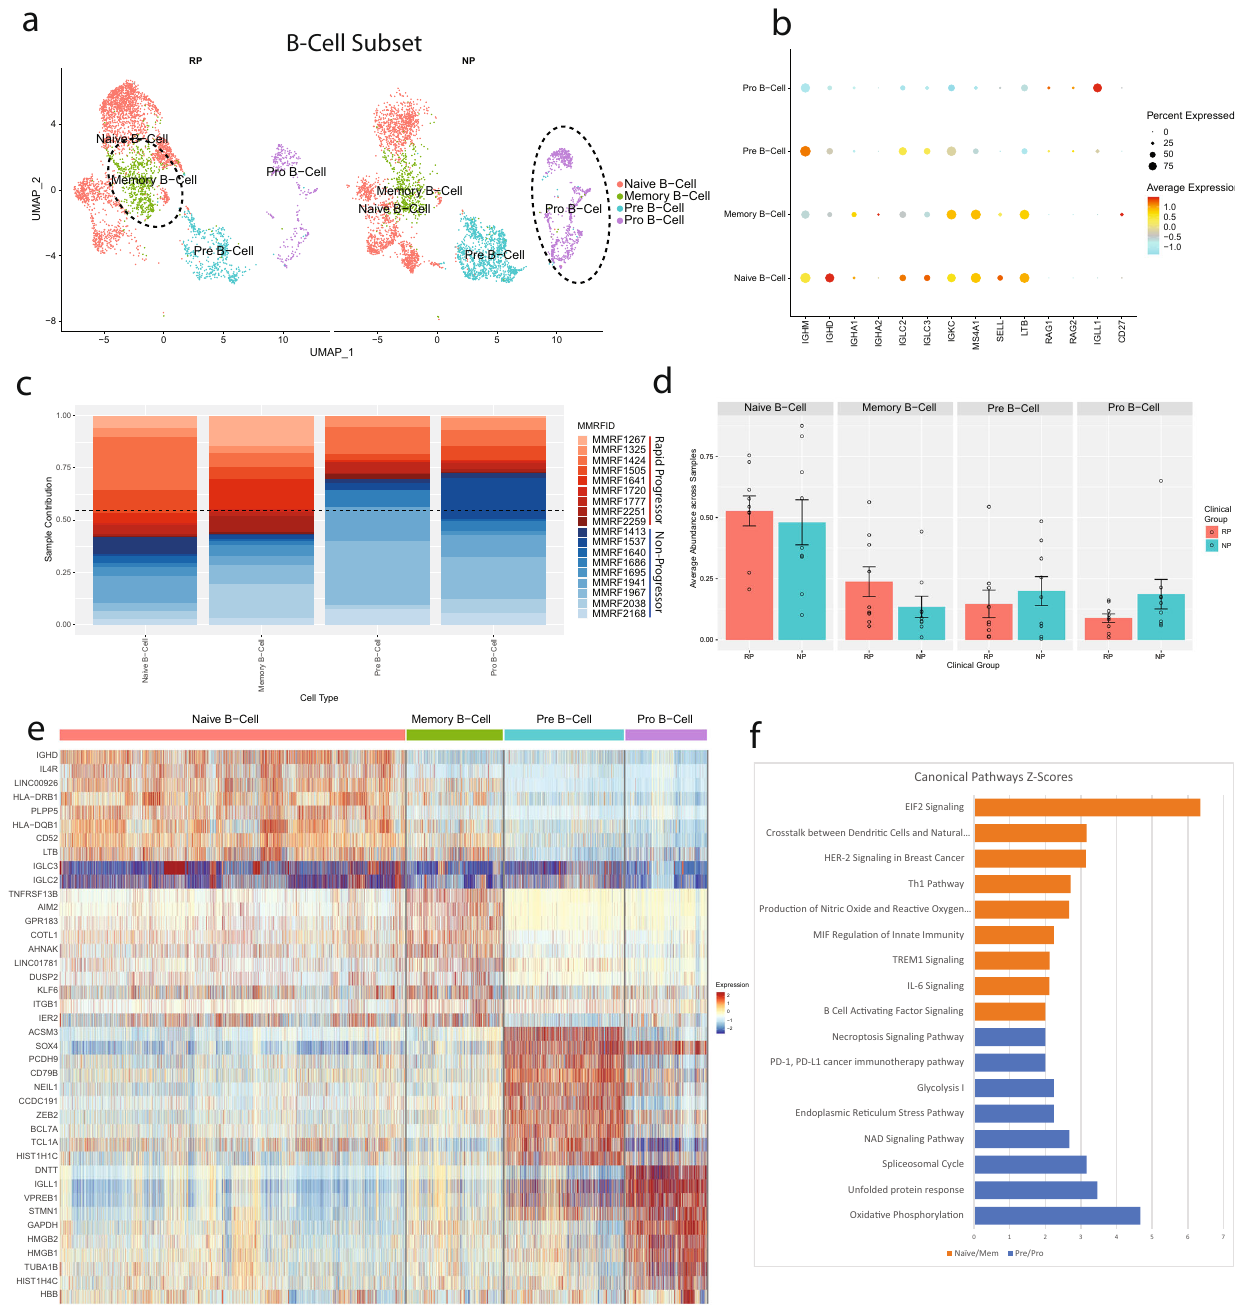
Fig. 5 Progenitor and precursor B-Cells are enriched in the multiple myeloma patients with no progression of the disease. a A UMAP displaying the B Cell subcluster split based on clinical groups (NP and RP). Subclusters were labeled as either pro B-cell, pre B-cell, memory B- cell, or naive B-cell based on expression of speci fi c markers. b A dot plot displaying the key markers used to identify each B cell subtype. Naive B-cells were identi fi ed via the expression of MS4A1 , SELL , and LTB . Memory B-cells were identi fi ed by expression of CD27 . Pre B-cells were identi fi ed by low MS4A1 expression. Pro B-cells were identi fi ed by the expression of RAG1 , RAG2 , and IGL11 . c The patient contribution to each cell type indicates most of the clusters consist of cells from multiple patients. The patients from the RP and NP groups are shown with shades of red and blue respectively. The majority of naive and memory B-cells are derived from samples of the RP group, while the majority of pre and progenitor B-cells are derived from samples of the NP group. d Comparative analysis of the B-cell types/subtypes in the RP and NP clinical groups. Each bar plot depicts average abundance across patients and error bars show the standard error of the mean. Individual dots represent the abundance of a cell type within an individual sample. Within the B-cell subtypes, there is no signi fi cant difference in the average patient ratio. e A heatmap, displaying the top differentially expressed marker genes for naive B-cells, memory B-cells, pre B-cells, and pro B-cells. Relative gene expression is shown in pseudo color, where blue represents downregulation, and red represents upregulation. f Pathway analysis was performed on the differentially expressed markers between mature and memory B-cell groups versus the pre and pro B-cells. Selected pathways that are signi fi cantly ( P -value < 0.01) enriched in these markers are displayed in the bar chart. Each bar represents a pathway with signi fi cant activation and inhibition in naive or memory B-cells based on Z-score calculated using the IPA analysis platform. The pathways that are signi fi cantly activated and inhibited in the naive and memory B-cells are shown with orange and blue bars